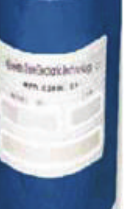
Figure 13: Acceleration sensor. Table 10: Positions and numbers of acceleration